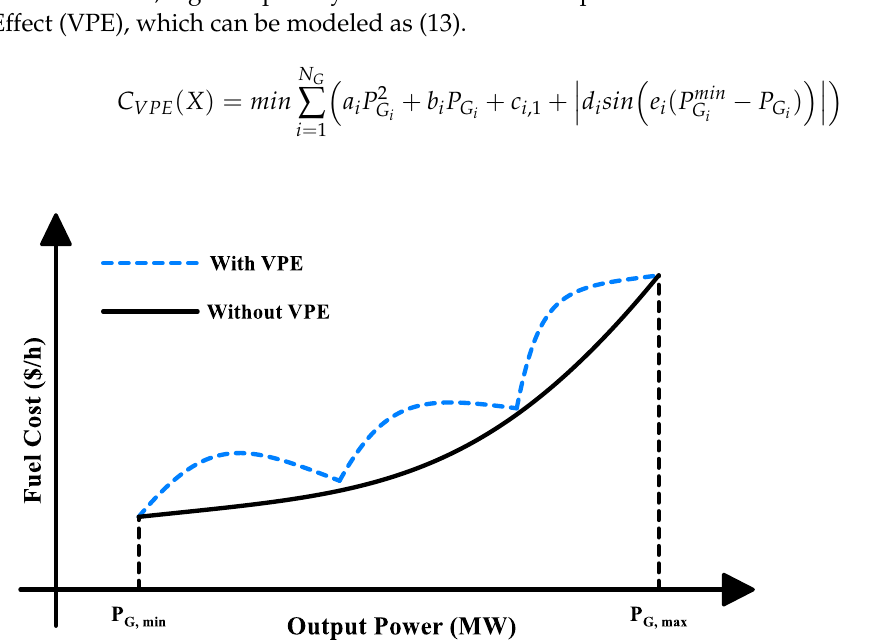
Figure 4. Curves of the cost function with and without the presence of Valve-Point Effect.